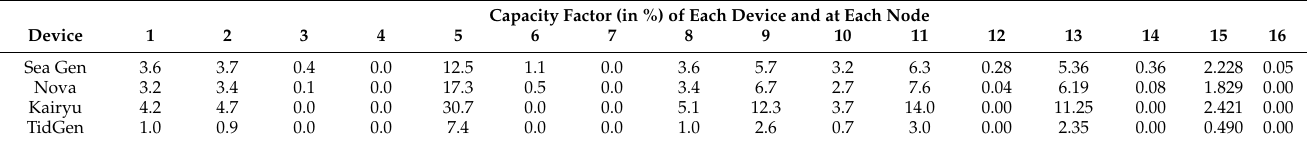
Table 4. Average Capacity Factor at 0 to − 50 m depth, for each node, for the four turbines.